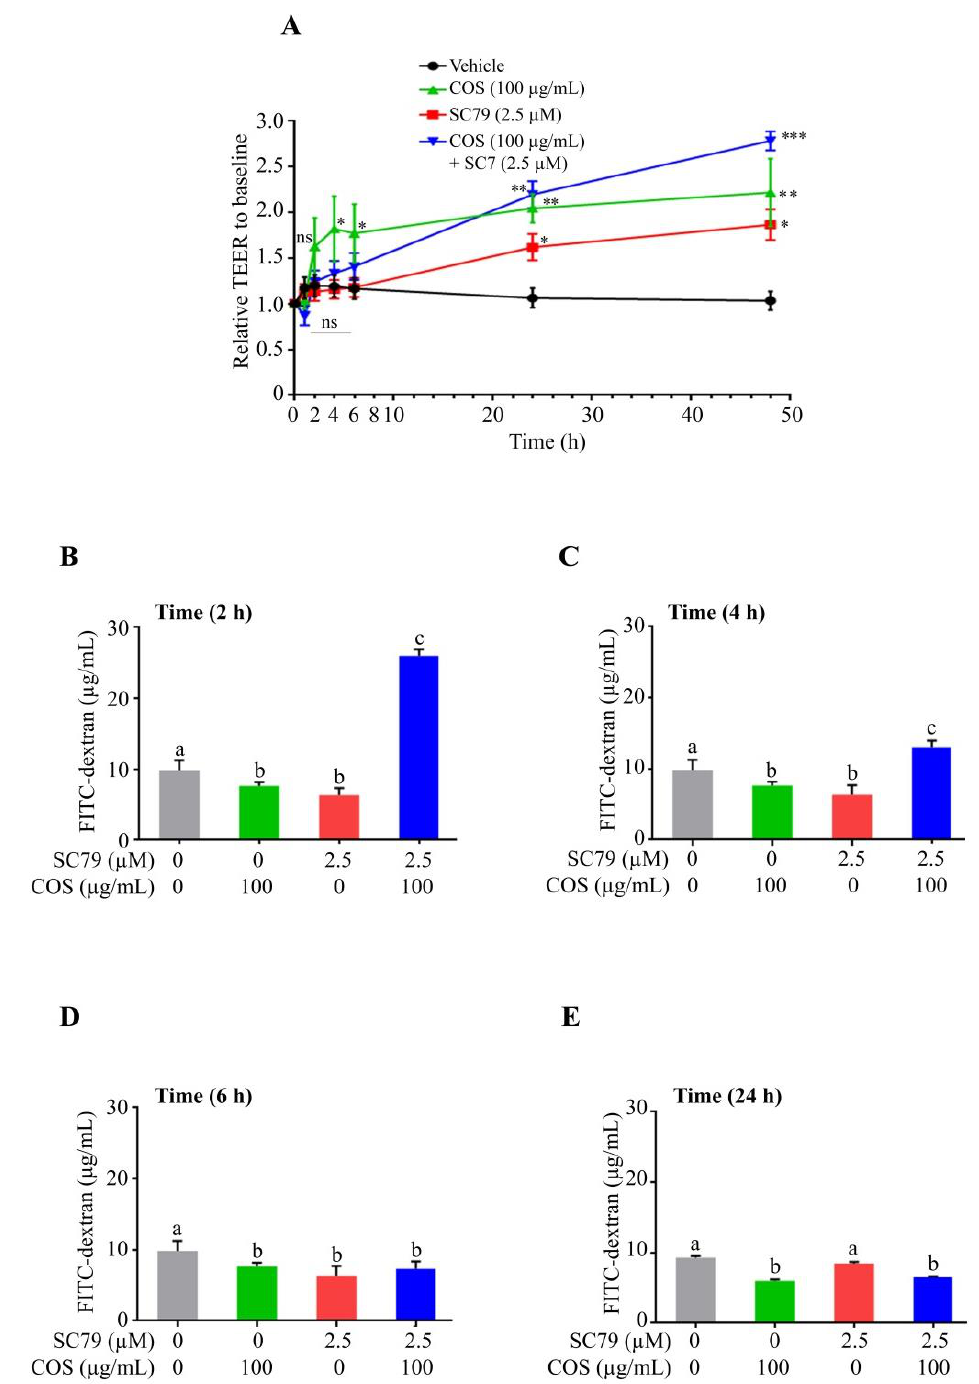
Figure 3. Effect of COS on barrier junction. ( A ) TEER across T84 cell monolayers was measured at indicated time intervals after treatment with indicated concentrations of COS and SC79 either alone or in combination. Data are expressed as the means of TEER ± S.D. ( n = 3) (one-way ANOVA; *, p < 0.05; **, p < 0.01; ***, p < 0.005; ns, non-significant; compared with vehicle treated group). ( B – E ). T84 cell monolayers were treated with indicated concentrations of COS and SC79 either alone or in combination for indicated time intervals followed by FITC-dextran flux assay. Data are expressed as means of FITC-dextran concentration ± S.D. ( n = 3; one-way ANOVA). Column not sharing the same superscript letter differ significantly ( p < 0.05, Tukey’s post hoc test).